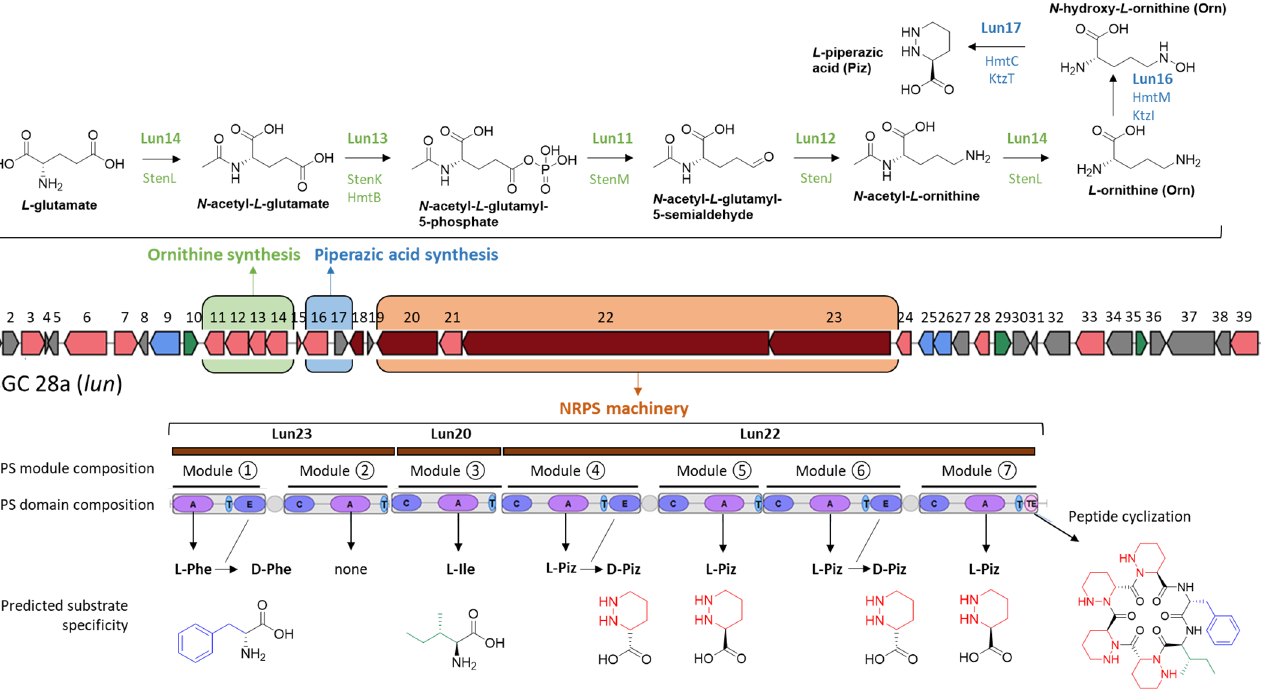
Figure 1 . Predicted biosynthetic pathways and substrate specificity of BGC 28a ( lun cluster). Top: genes/proteins predicted to be involved in the Ornithine (Orn) and Piperazic acid (Piz) biosynthesis. Bottom: modules, domains, predicted amino acid building-blocks, and modifying reactions of NRPSs of BGC 28a predicted to generate a cyclized hexapeptide with a monoisotopic mass of 708.4041 Da. Abbreviations: A, adenylation domain; C, condensation domain; T, thiolation domain;